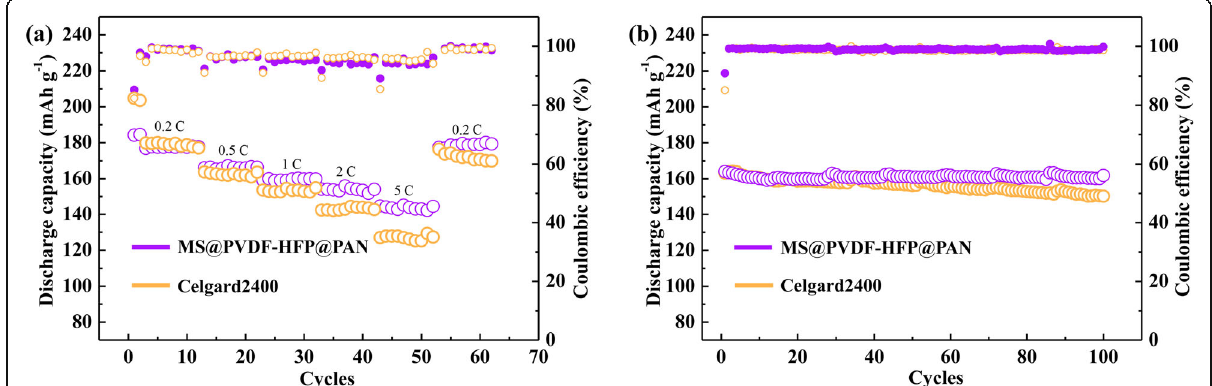
Fig. 4 Electrochemical performances of the NMC622 half cells using MS@PVDF-HFP@PAN and Celgard separators. a The rate performances over a range of applied voltage of 2.8 – 4.3 V at a constant C-rate of 0.2 to 5 C. b Cycling performances under the same